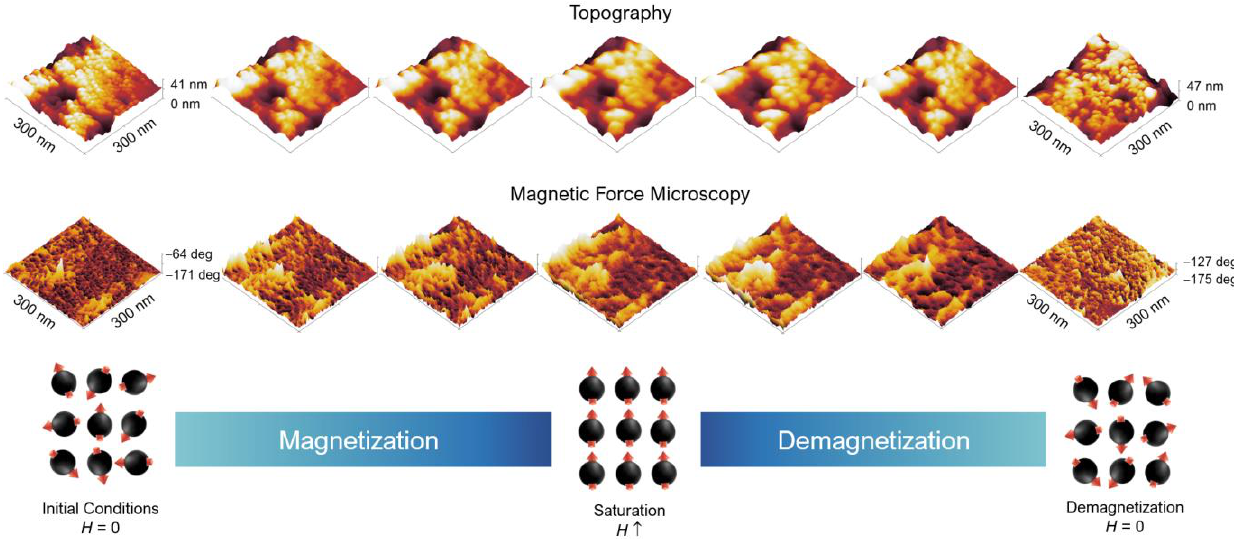
Figure 7. Topography and magnetic domains of G-M@T samples: Magnetic domains in the core region and orientation in response to the AC field, attractive (brighter zones) or repulsive (darker zones) interactions.